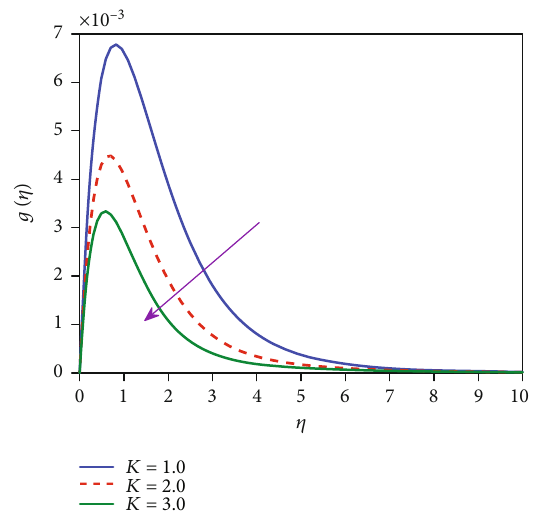
Figure 25: E ff ect of K on the concentration ϕ ð η Þ .